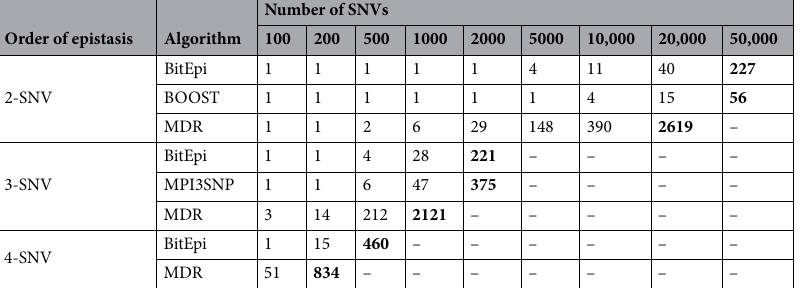
Table 2. The execution time (in s) of epistasis algorithms for 2000 samples and different numbers of SNVs. The process is killed if it takes more than an hour to complete and the execution time is not measured. If the execution time is less than a second it is reported as 1 in this table. All programs are executed with 16 parallel threads. Highlighted execution times are used to compute the average test time (see Fig. 3).